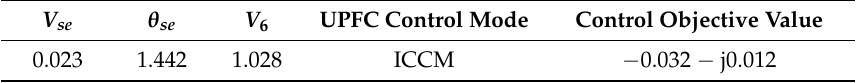
Table 3. The optimized parameters, control mode, and control objective value of UPFC.